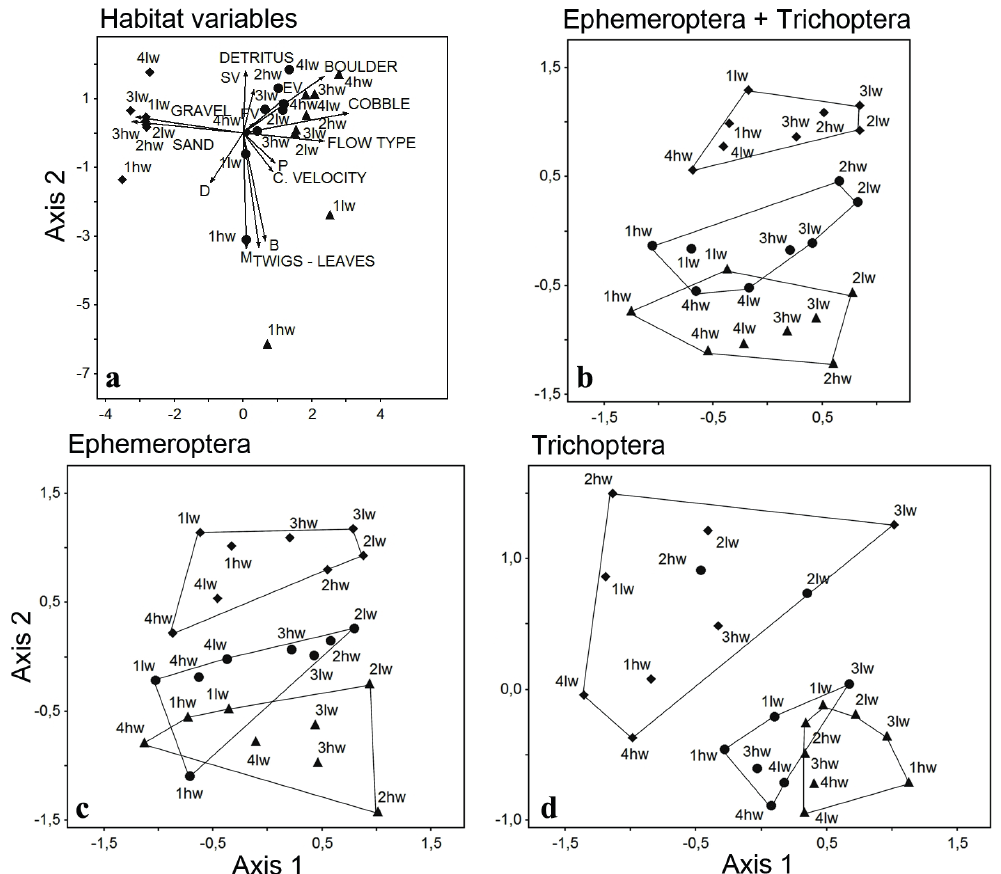
Figure 3 – PCA of habitat variables (plot a ) and NMDS of ephemeroptera+Trichoptera assemblages (plot b ), ephemeroptera (plot c ) and Trichoptera (plot d ) in 3 different stream habitats: riffles (triangles), coarse substrate runs (circles) and fine substrate runs (diamond) in 4 streams (1, 2, 3, 4) during high (hw) and low water periods (lw). each dot corresponds to the average of 3 spatial replicates, 2 temporal replicates, and 2